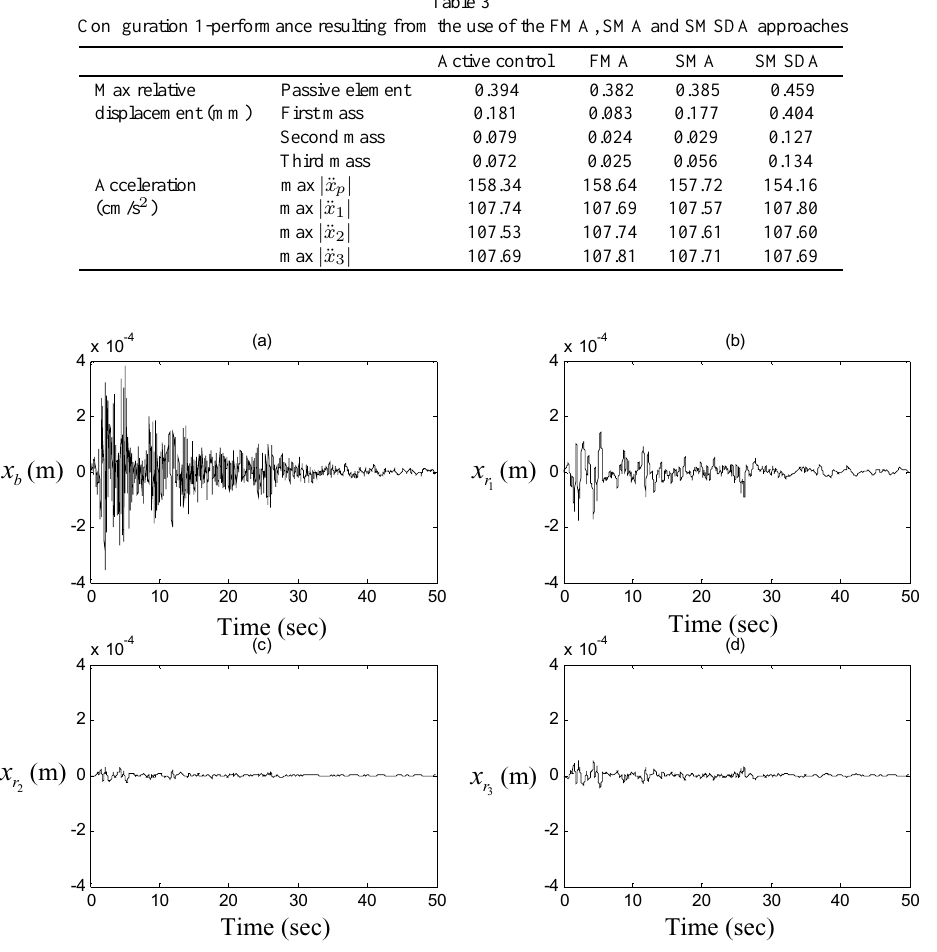
Fig. 7. Relative displacement simulations of passive controlled system by confinement with the SMA approach. (a) Passive element x r 1 = x p ; (b) First mass x r 2 = x 1 ; (c) Second mass x r 3 = x 2 − x 1 ; (d) Third mass x r 4 = x 3 − x 2